Question: Condense the content of this figure into a single sentence.
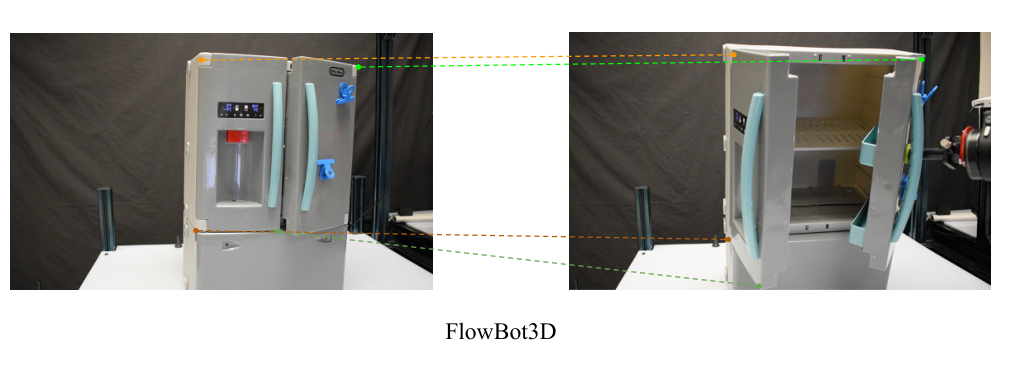
Answer: FlowBot++ Reducing Unwanted Movements of the Object. Top: FlowBot++ opens the left door of the fridge. The position and pose of the body of the fridge remain unchanged. Bottom: FlowBot3D opens the right door of the fridge. Due to wrong flow prediction at intermediate steps, the gripper yanks the fridge too hard that it tips over, causing unwanted motions of the fridge and opening the wrong door by accident.